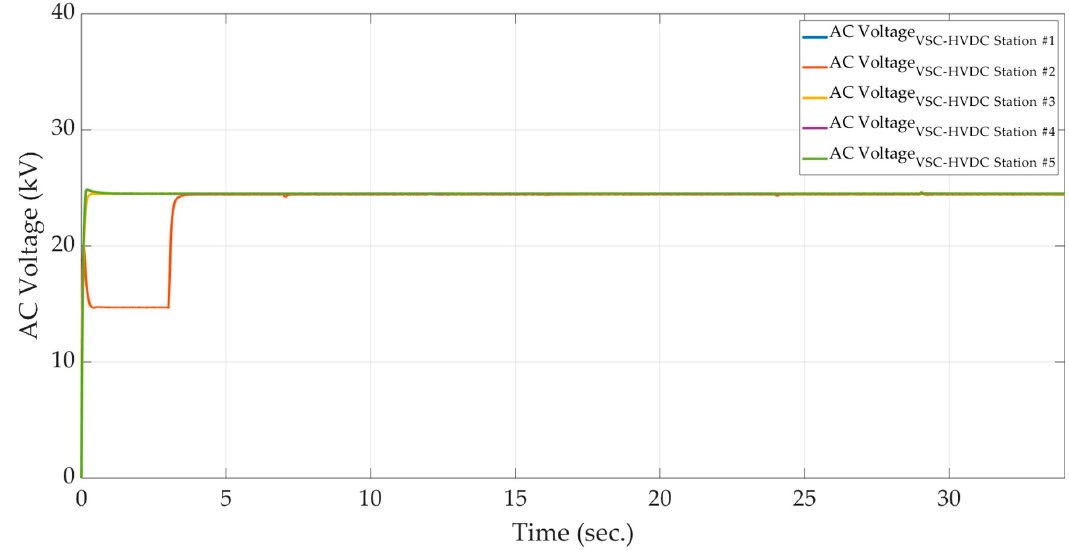
Electronics 2020 , 9 , 87 Figure 14. The AC voltage profile of di ff erent VSC-HVDC stations in the second scenario. Figure 14. The AC voltage profile of different VSC-HVDC stations in the second scenario.